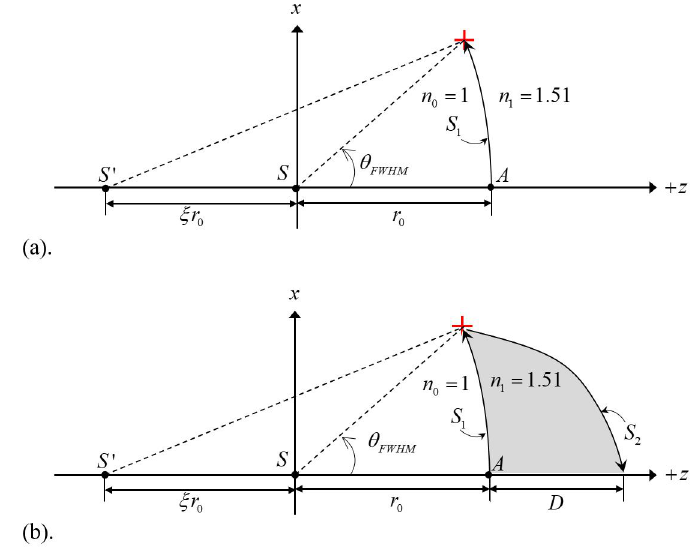
Figure 2. The analytic collimating lens is designed by: ( a ) selecting r 0 and ξ to determine S 1 starting from point A and ended with an aperture angle of θ FWHM , ( b ) constructing S 2 staring from the symbol + and ended at the distance of D relative to point A on the optical